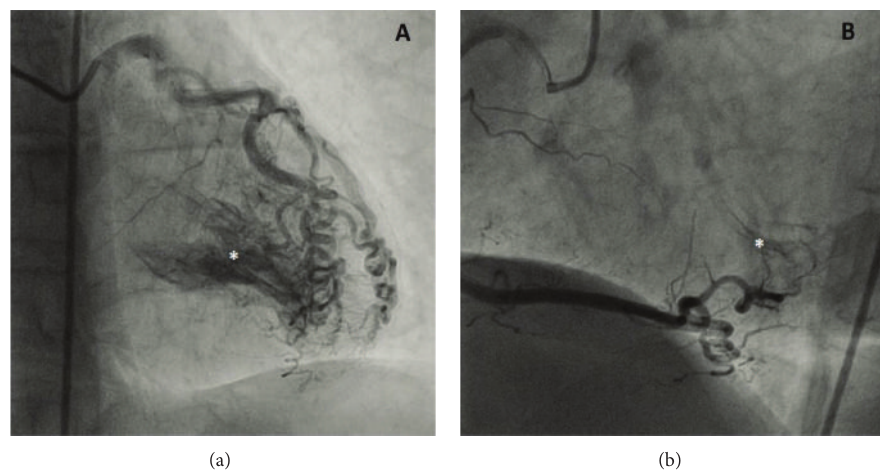
Figure 2: (a) Frames of anteroposterior oblique projection of left coronary angiogram depicting the CCFs opacifying the left ventricular cavity (asterisk) originating from the left coronary arterial system and (b) left oblique projection of right coronary angiogram demonstrating the opacification of the left ventricular cavity (asterisk) by microfistulae from the distal right coronary artery.